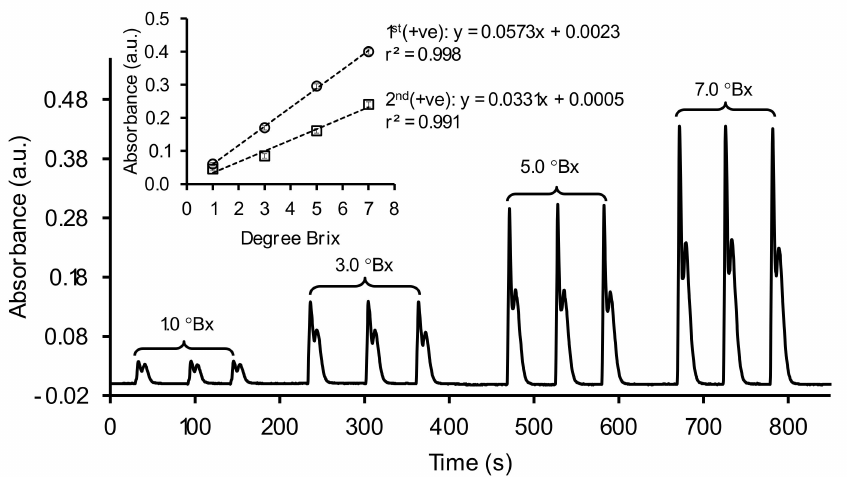
Figure 3. The Schlieren signal obtained from various standard sucrose solutions (1.0 to 7.0 ◦ Bx) under the detection wavelength of 1000 nm. Inset: linear calibration graphs obtained from data acquisition with two positive